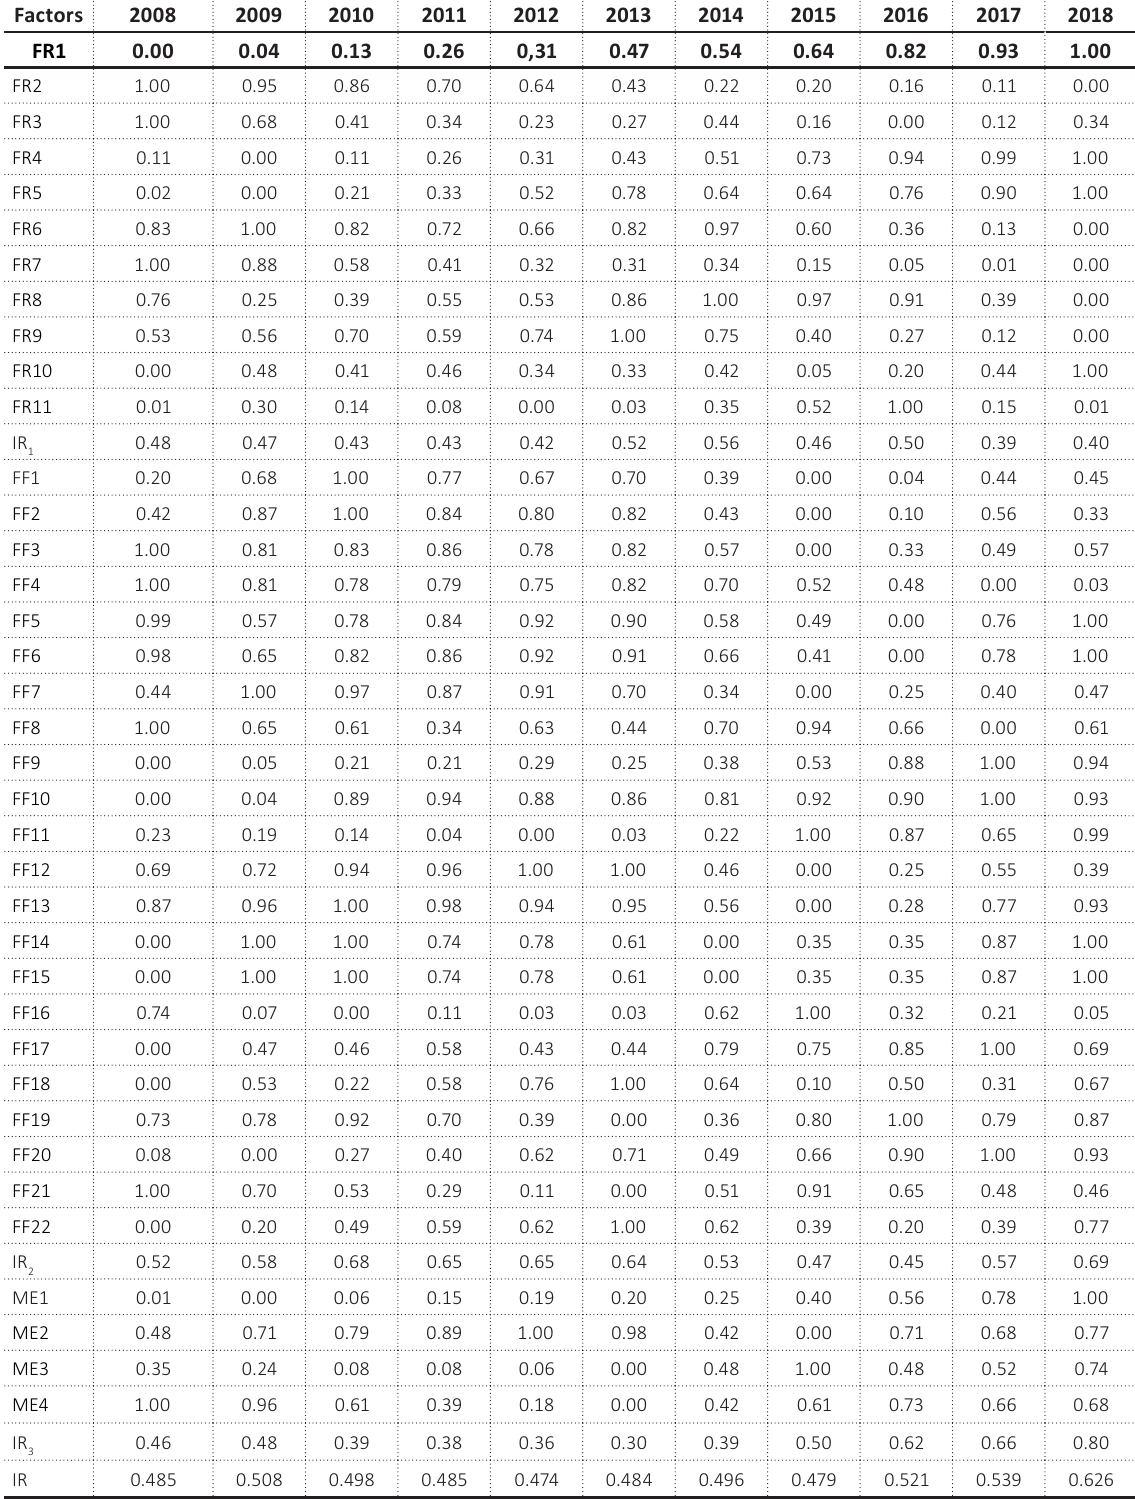
Table C1. Standardized values of indicators of the components, partial integral indicators ( IR and total integrated indicator ( IR )